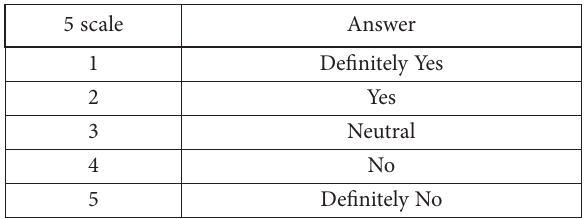
Table 1. The five scales of the questionnaire (Zahid, 2021)